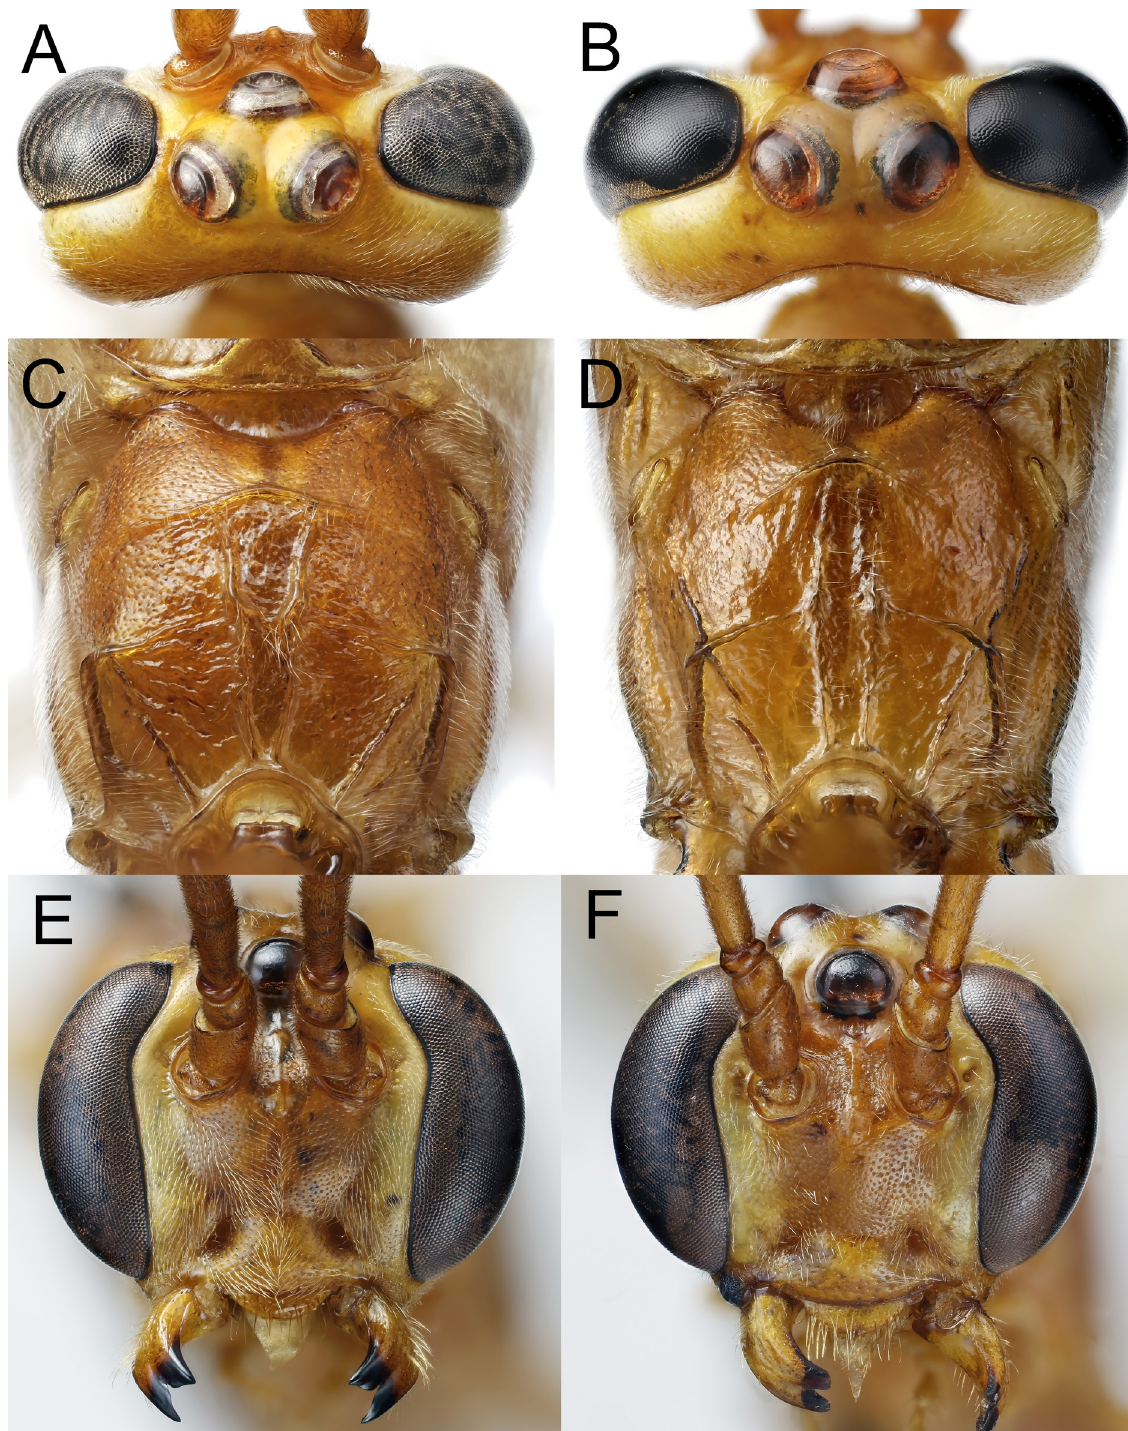
Fig. 14. A–B . head, dorsal view of female. A . Ophion luteus (Linnaeus, 1758). B . O. slaviceki Kriechbaumer, 1892. C–D . Propodeum, posterodorsal view. C . O. borealis Johansson sp. nov.,